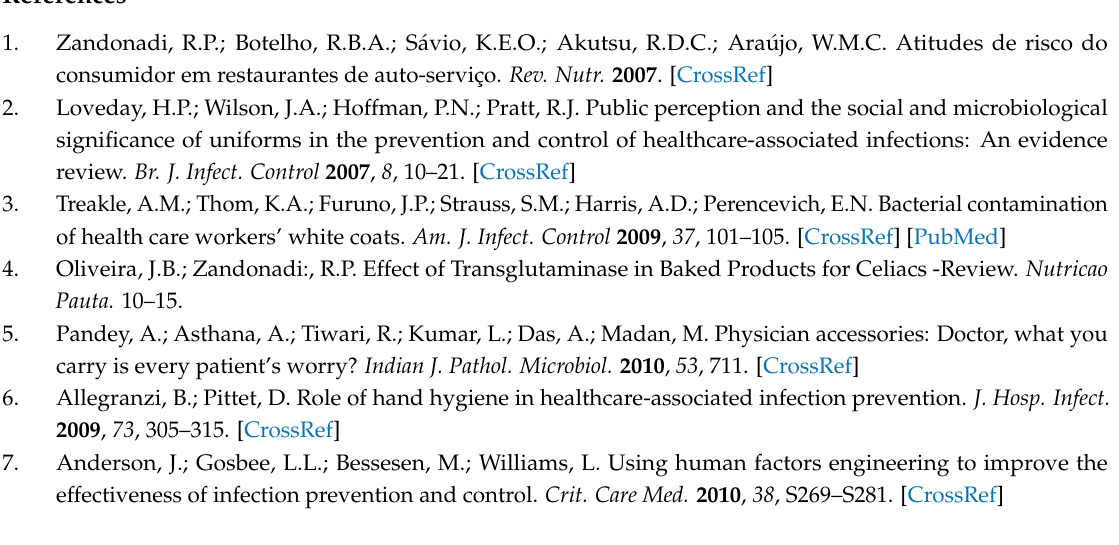
s1, Table S1: Registration of the available resources in the public hospitals of the Brazilian Federal District; Table S2: Unhygienic practices instrument part 1: registration of the use of work uniforms and working instruments, hand hygiene and/or the use of the alcohol gel; Table S3: Unhygienic practices instrument part 2: registration of customers´ contaminating practices during dish assembling; Table S4: Questionnaire to identify the stage of behavioural change in regard to contaminating practices in hospital